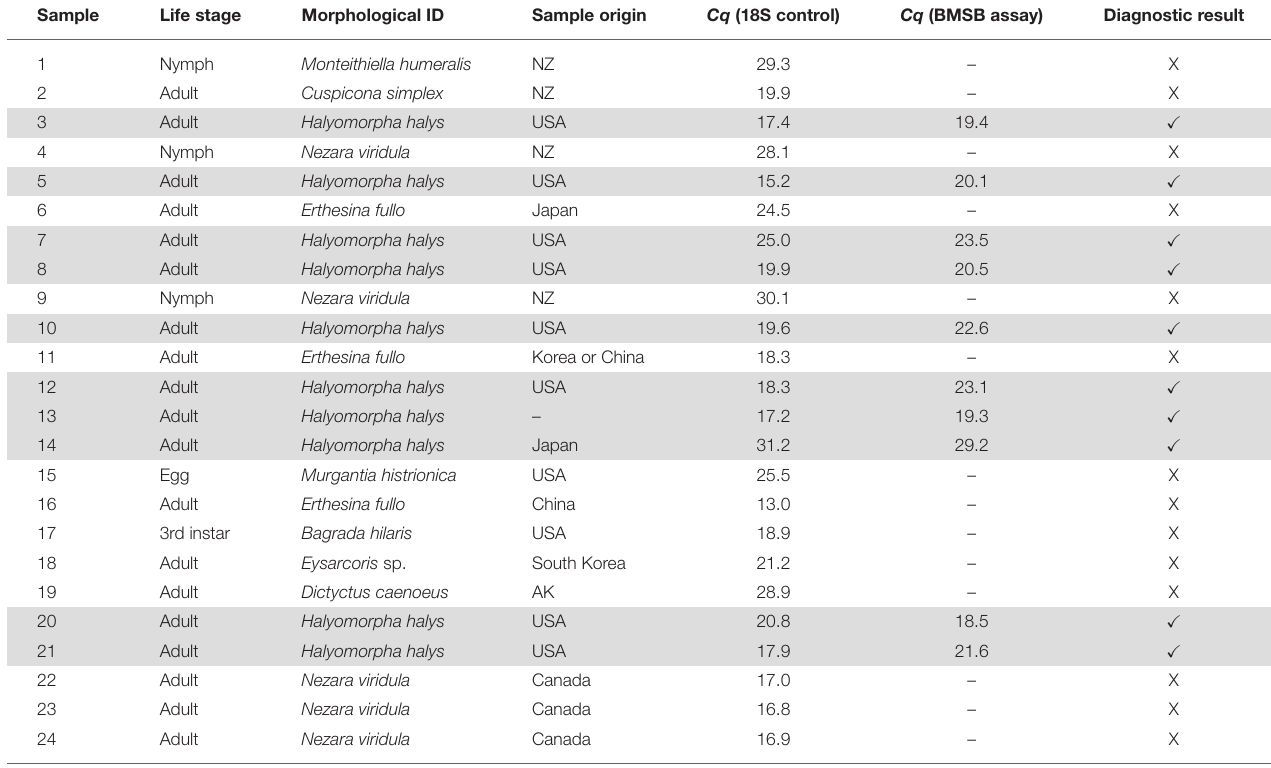
TABLE 3 | Blind panel testing of BMSB assay.